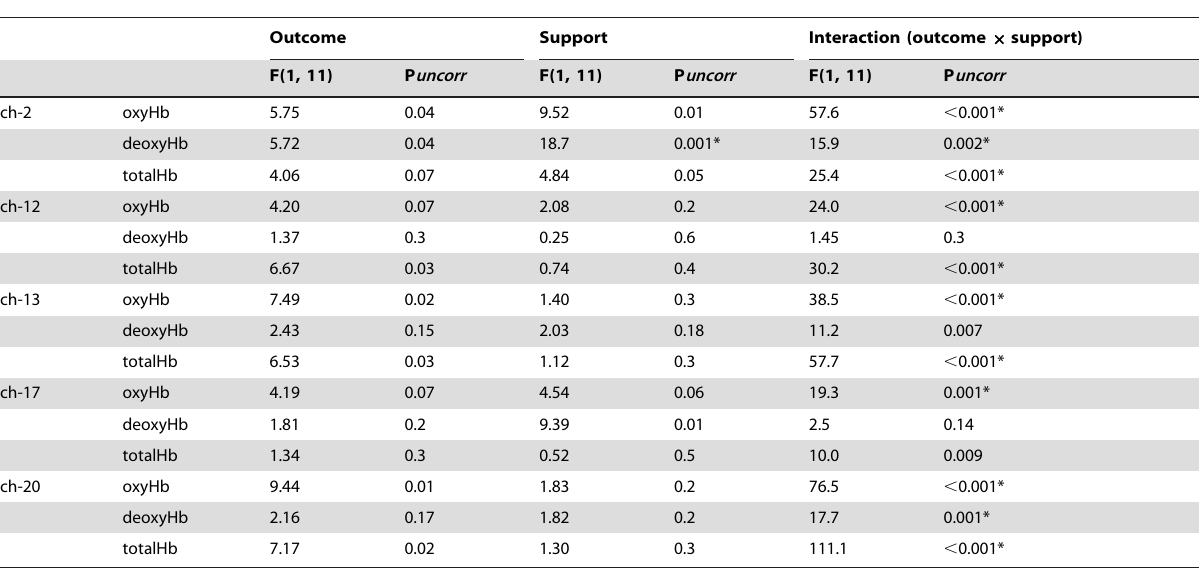
Table 1. Statistical results of the 2 6 2 analysis of variance for each NIRS parameter.